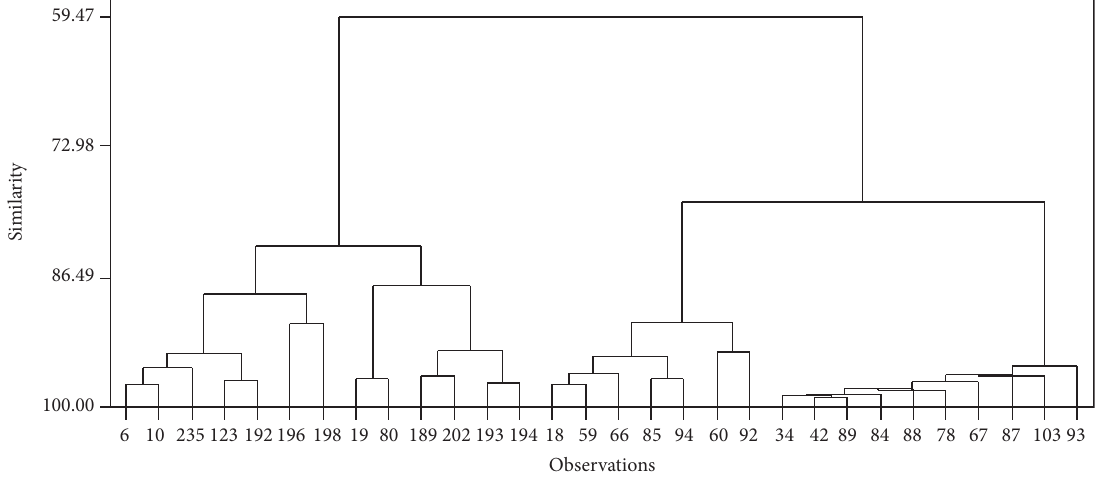
Figure 1: Clustering of Dalbergia sissoo clones on the basis morphological, physiological, and biochemical parameters with Euclidean method and the Ward linkage cluster analysis. Table 4: Correlation matrix among the various characters of Dalbergia sissoo clones.